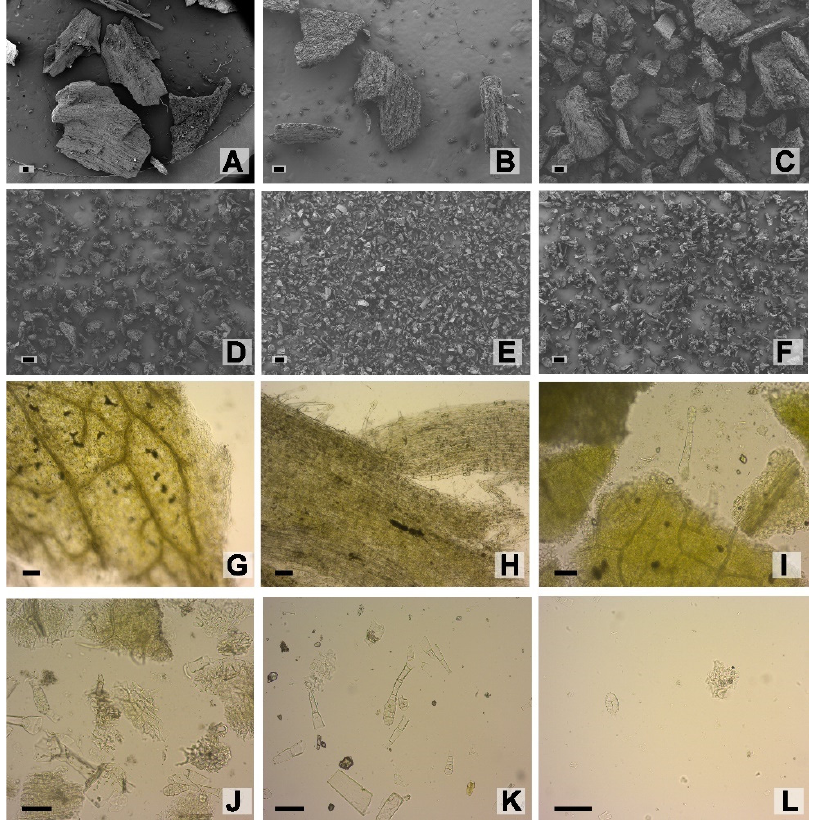
Figure 5. Nicotiana tabacum var. Virginia leaf waste powder. Sieved fractions from ground leaf waste.